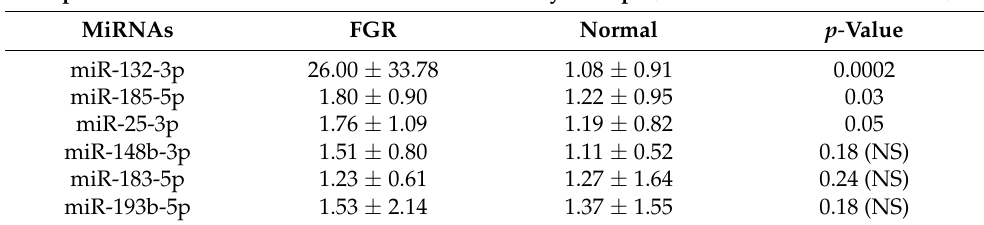
Figure 2. Violin plots representing PCR validation results of miR-132, miR-185 and miR-25. MiRNA results are expressed as 2 −ΔΔCt . Table 1. RT-qPCR validation of miRNAs in FGR and normal fetuses. miR-132-3p was also included in the analysis according to previous references. Only miR-185-5p, miR-25-3p and miR-132-3p showed statistically significant differences. Values are expressed in 2 − ∆∆ Ct